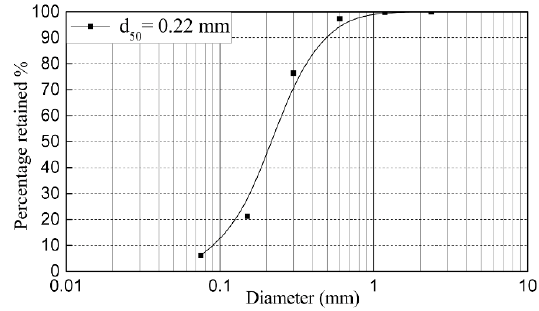
Figure 2. The particle gradation curve.